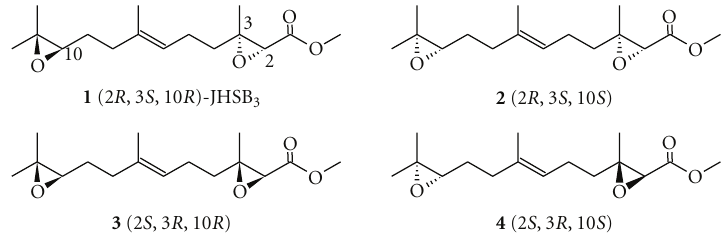
Figure 4: Four stereoisomers of JHSB 3 .